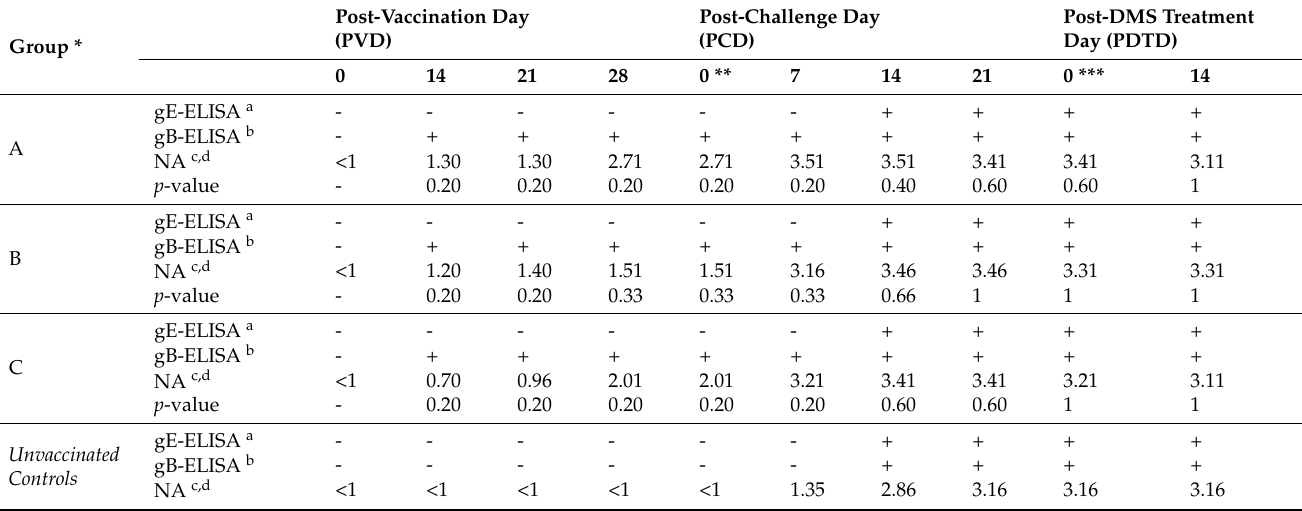
Table 2. Antibody response of calves immunized with different BoHV-1 marker vaccines, challenge infected with virulent strain of BoHV-1, and treated with dexamethasone